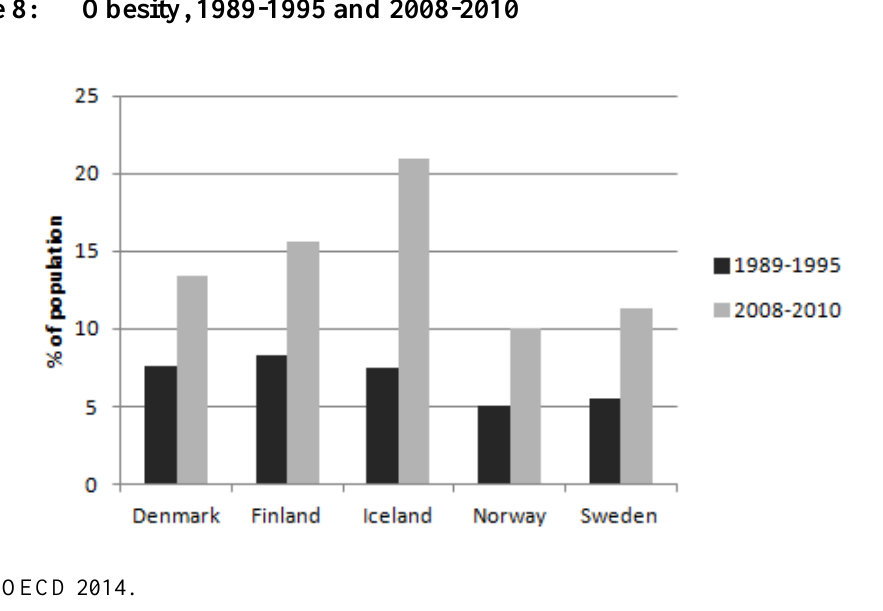
Figure 8: Obesity, 1989-1995 and